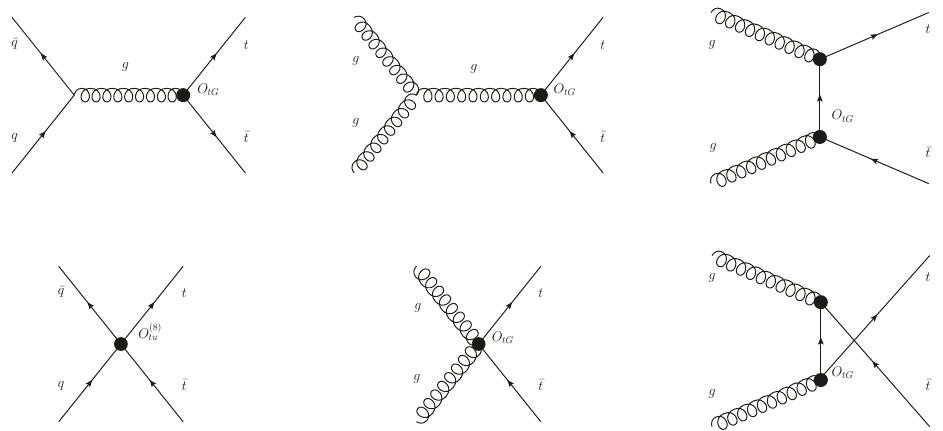
Figure 2. Representative Feynman diagrams for parton-level top-quark pair production in the SMEFT, indicating some of the corrections induced by the O tG and O (8) both modify existing SM interaction vertices, such as gt ¯ t , and induce new ones, such as ggt ¯ t . The operators considered do not modify top quark